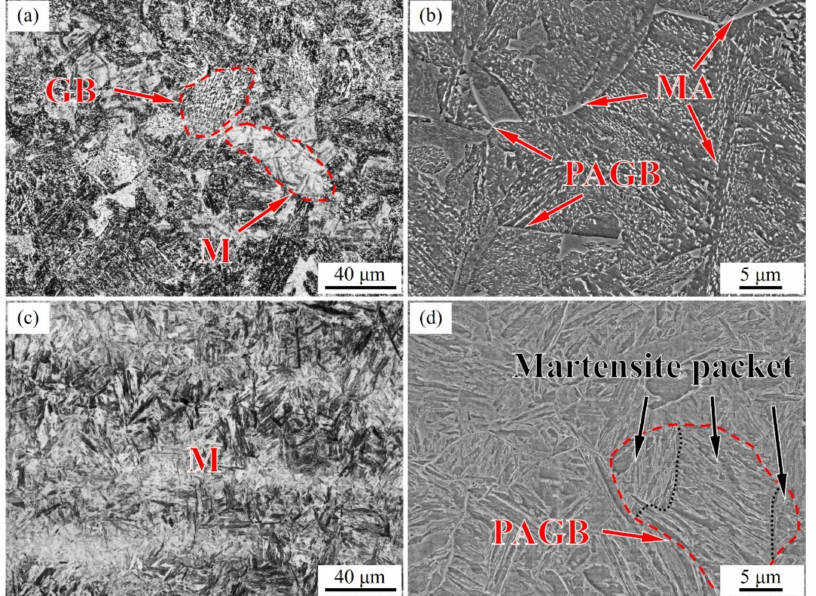
Figure 1. Microstructure of as-normalized and as-quenched. ( a , b ) OM and SEM images of normaliz- ing; ( c , d ) OM and SEM images of quenching. GB: granular bainite, M: martensite, MA: martensite- austenite constituent, PAGB: prior austenite grain boundary.